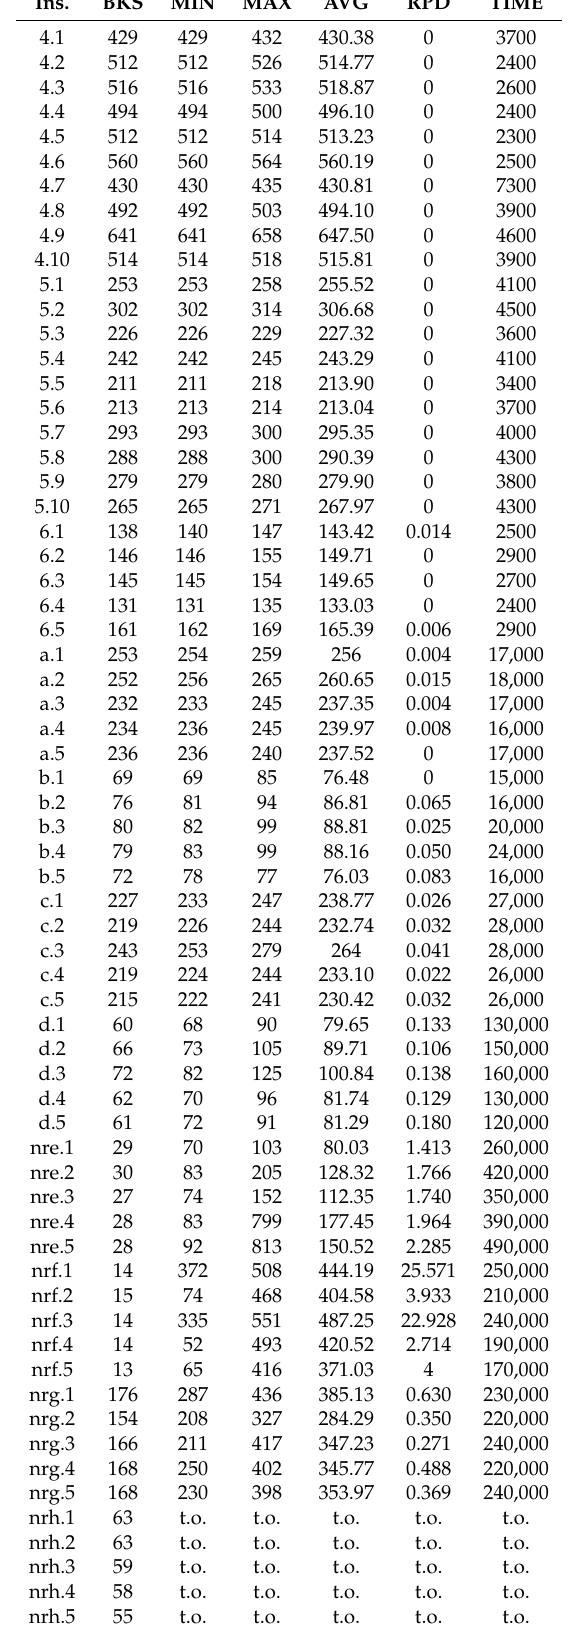
Table A11. DBscan results set (t.o = time